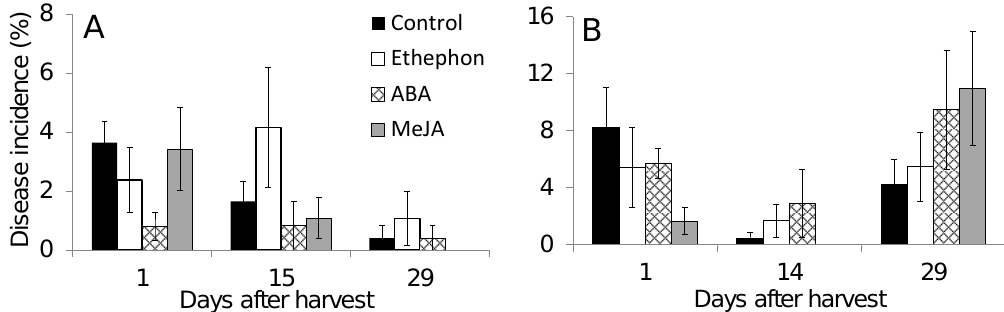
Figure 2. Percent postharvest disease incidence determined at various times after harvest in Premier ( A ) and Powderblue ( B ) rabbiteye blueberry following applications of water (control), ethephon, abscisic acid (ABA), and methyl jasmonate (MeJA). Values are means and standard errors of four replicates and 40 to 60 fruit per replicate. No significant differences (α = 0.05) were detected among the treatments.